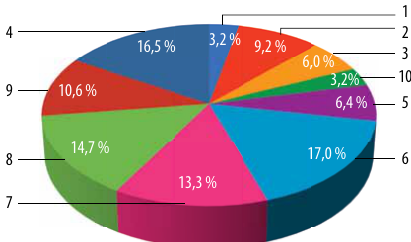
fig. 2. The results of the summarized survey “ What kind of facil- ities should be installed in the building for independent studies?”